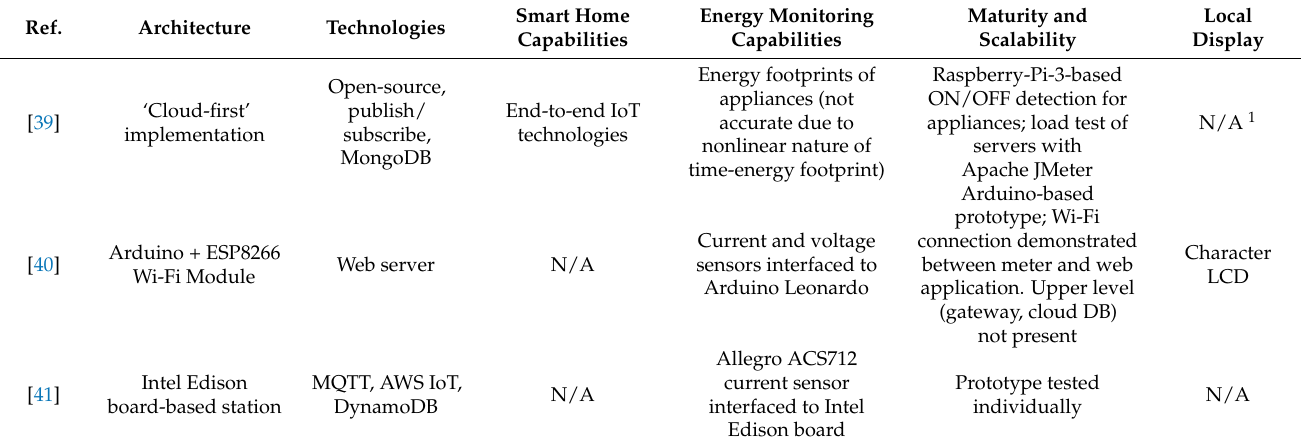
Table 2. Smart-home systems, energy-monitoring devices, and energy-monitoring platforms.